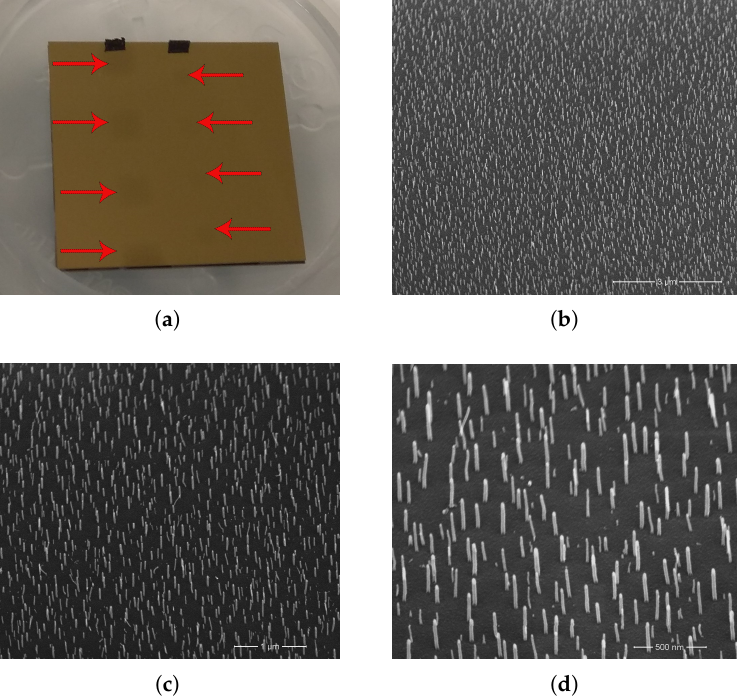
Figure 7. ( a ) Photograph of a sample where a color gradient is observable (evidenced by the red arrows) due to the localized growth of VA-CNTs. SEM micrographs at a 60 ◦ tilt angle and ( b ) 25,000×, ( c ) 50,000 × , and ( d ) 100,000 × magnification of the zones evidenced by red arrows in ( a